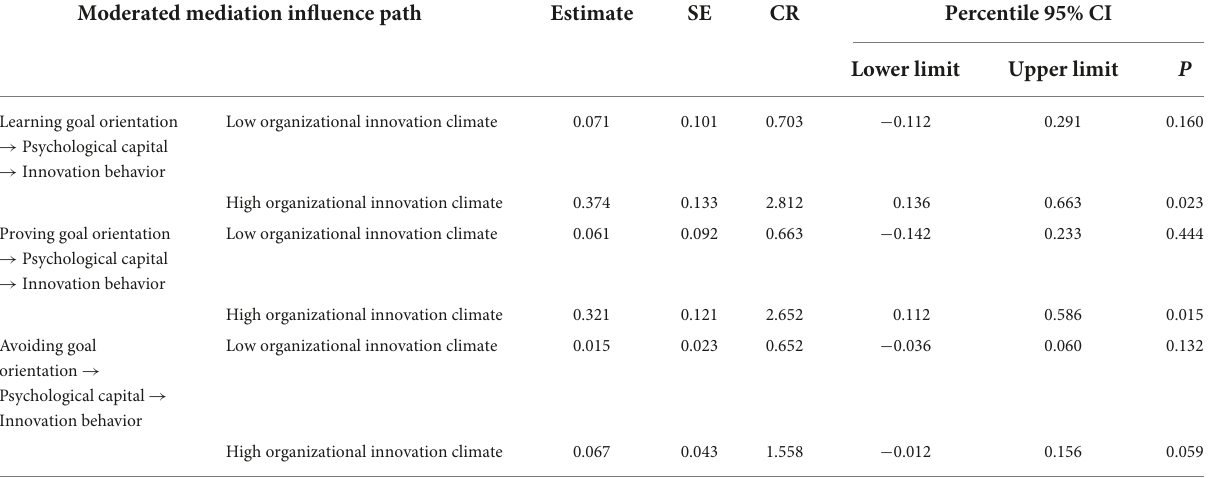
TABLE 7 Moderated mediation effect test of psychological capital and organizational innovation climate. Moderated mediation influence